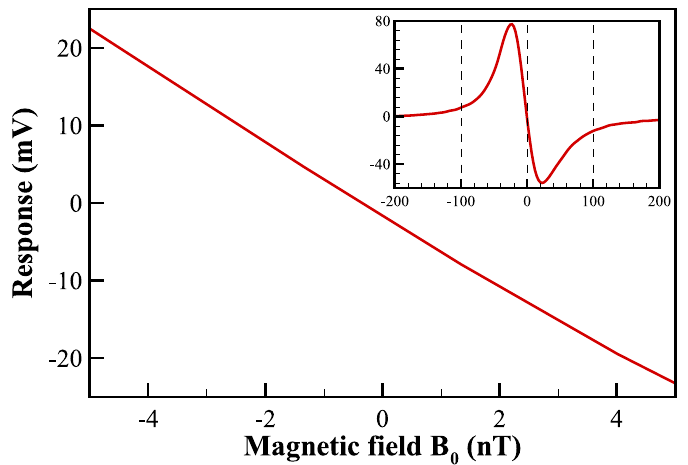
Figure 4. Response of the demodulated signal with respect to the magnetic field B 0 . The inset shows the response to a wider range of magnetic fields ranging from − 200 nT to 200